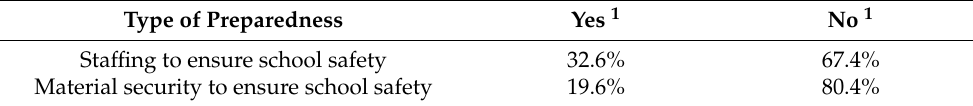
Table 3. Responsiveness to ensure school safety.